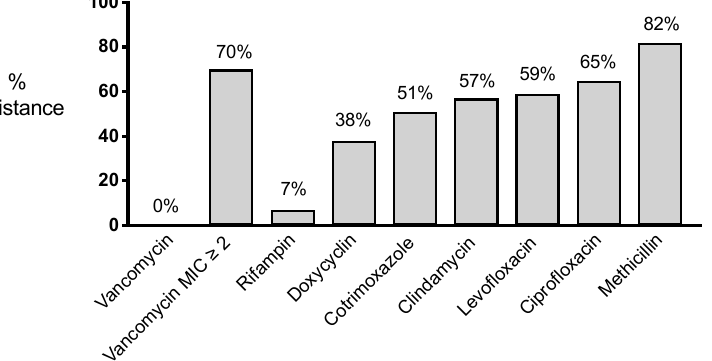
Figure 1. Percentage of resistance for different antibiotics in S. epidermidis strains isolated from patients with an early PJI ( n = 157).